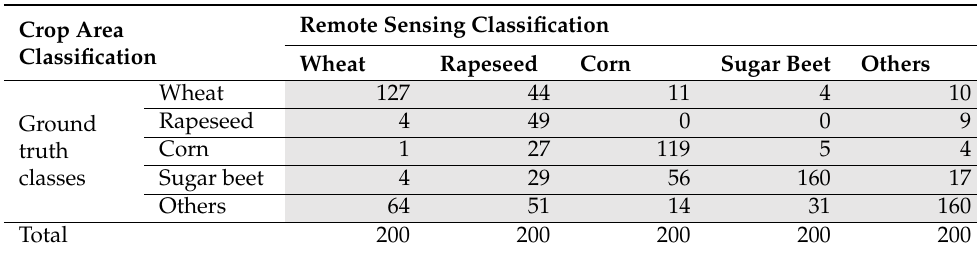
Table 4. Test points classification using RS strategy, with 200 pixels selected by simple random sampling from each set of remote sensing class independently.